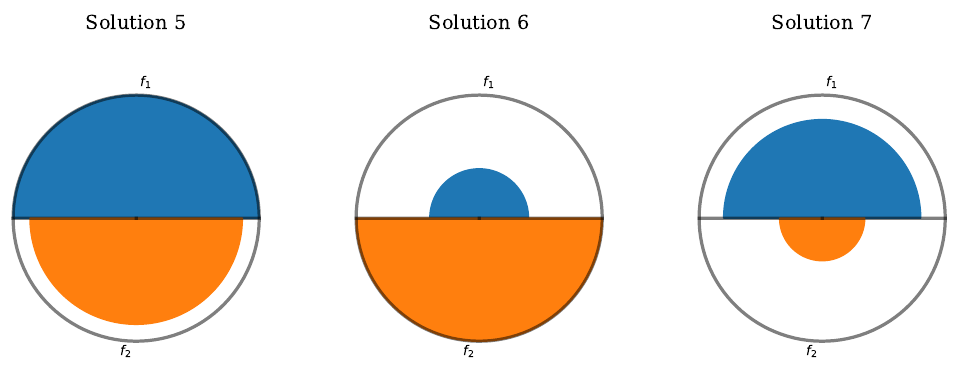
Figure 7. Visualization of three solutions using petal